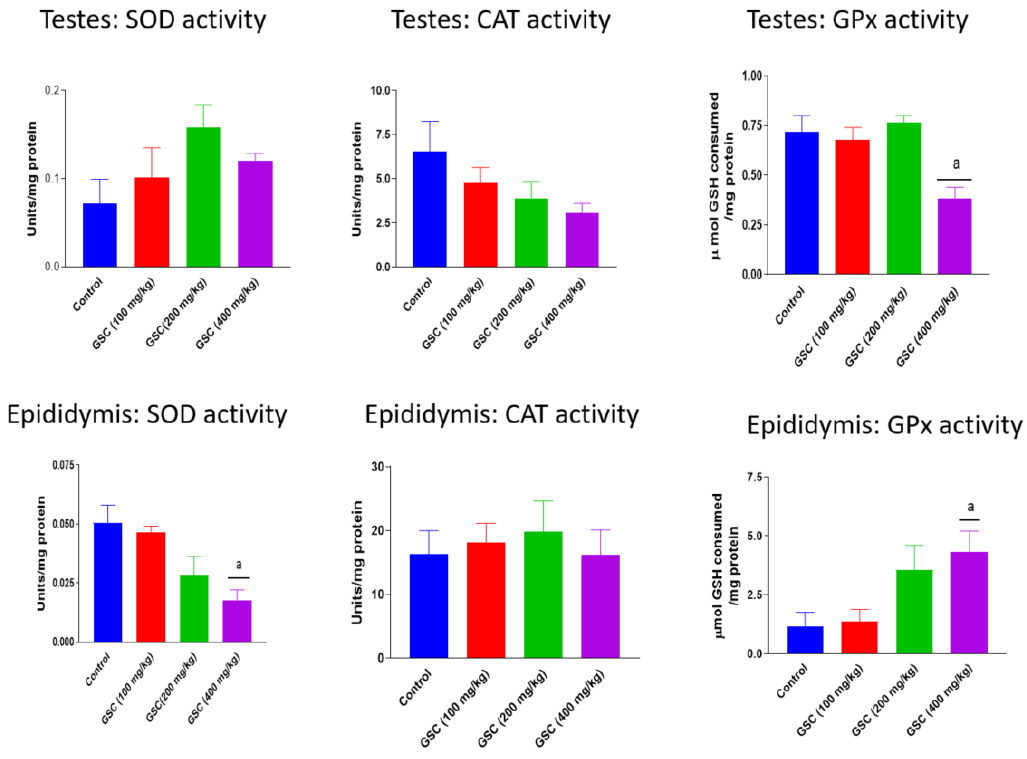
Figure 1. Effect of green-synthesized cellulose (GSC) on antioxidant enzyme activities in testes and epididymis of rats. Values are expressed as mean ±SEM (n = 5). a Significantly different from control ( p < 0.05). SOD—superoxide dismutase; CAT—catalase; GPx—glutathione peroxidase.